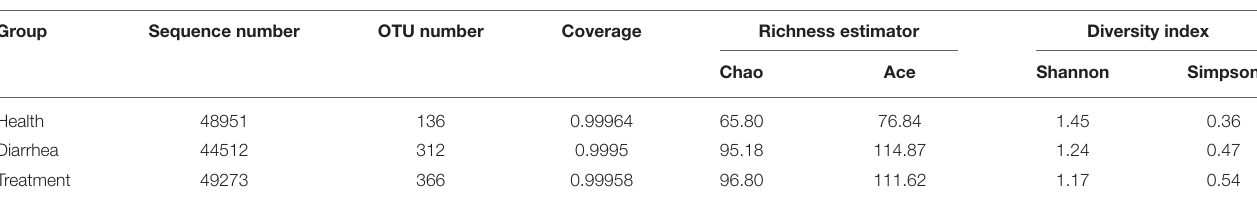
TABLE 2 | Alpha diversity based on OTU levels in infant